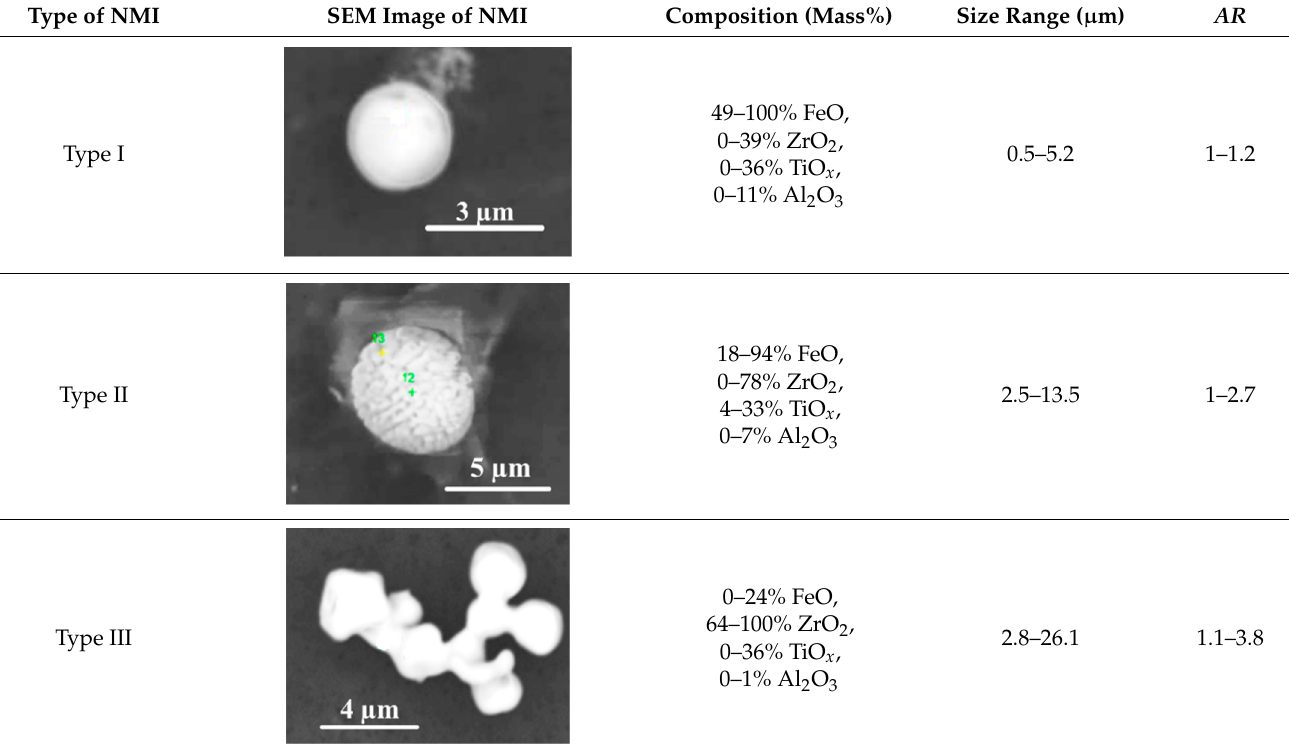
Table 3. Classification of different NMIs observed in Ti/Zr experiments after EE.